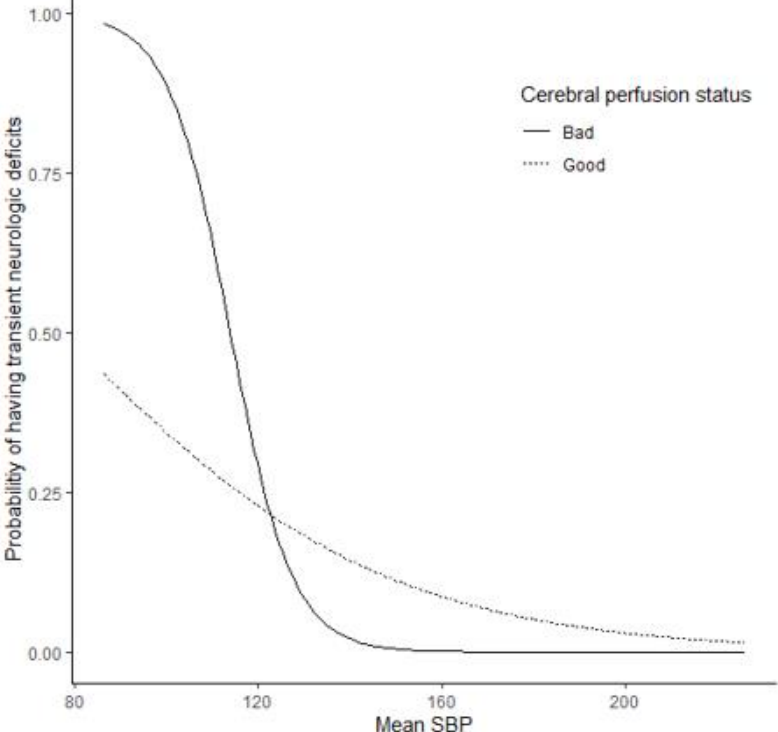
site of operation, and no previous stroke.